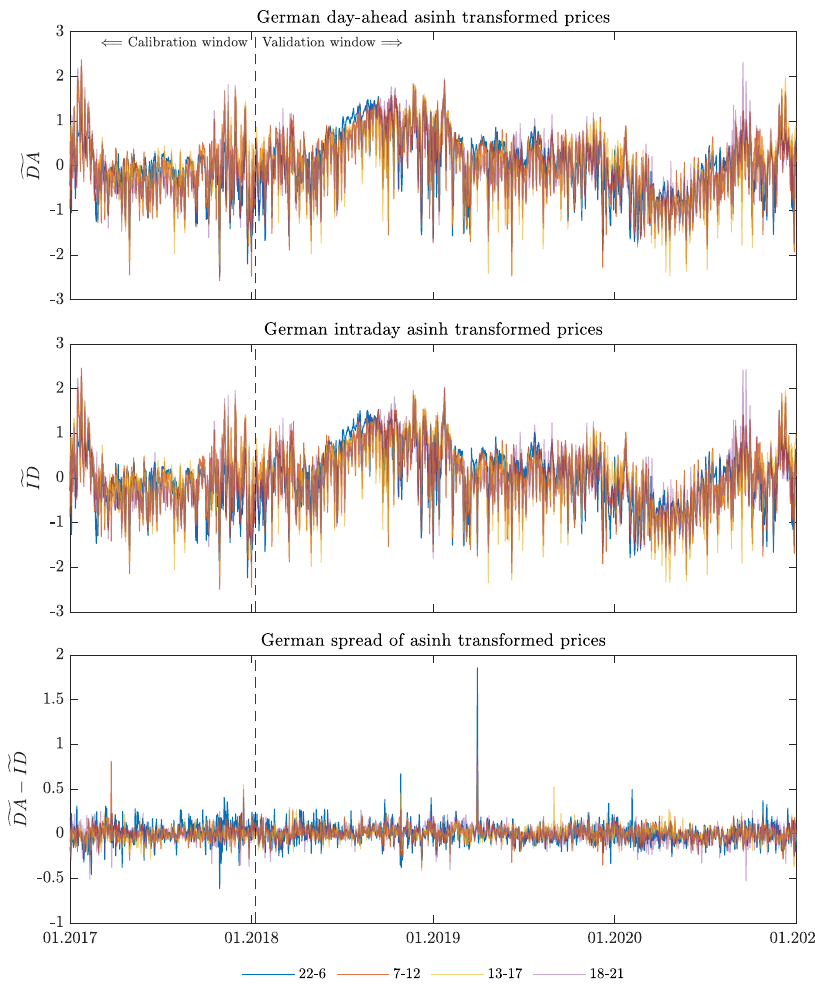
Figure A1. German day-ahead prices ( top panel), intraday prices ( middle panel) and the spread ( bottom panel) after the asinh transformation. For illustration the hourly prices were averaged over four representatives blocks of hours: 22–6 (night), 7–12 (morning peak), 13–17 (midday), 18–21 (evening peak). Source: Authors’